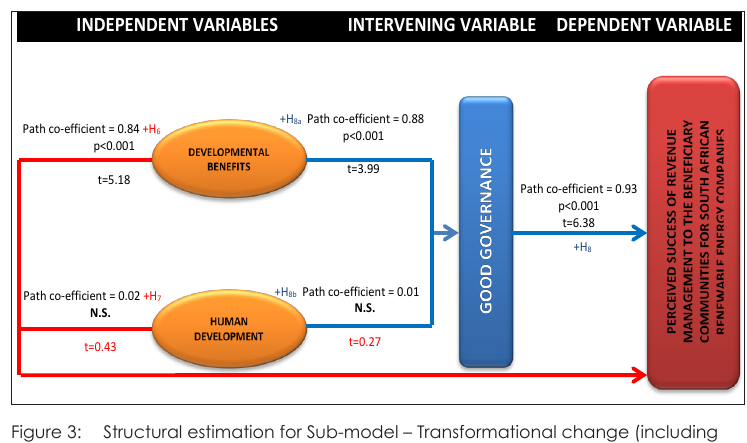
Figure 3: Structural estimation for Sub-model – Transformational change (including t-values) where N.S. =